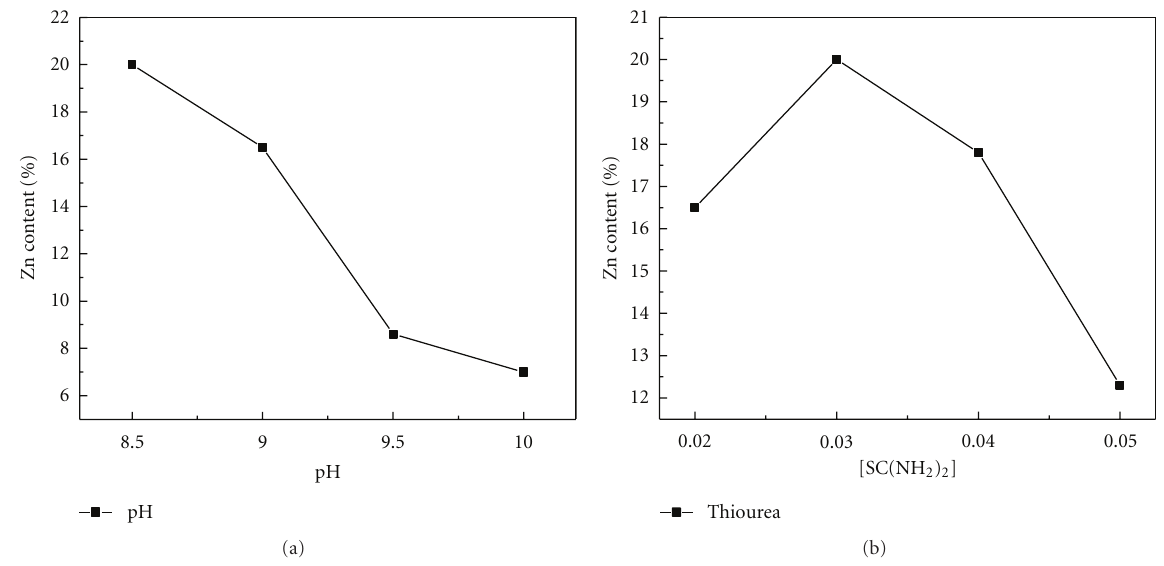
Figure 4: Plots of Zn content versus di ff erent deposition conditions of Cd 1 − x Zn x S thin films.